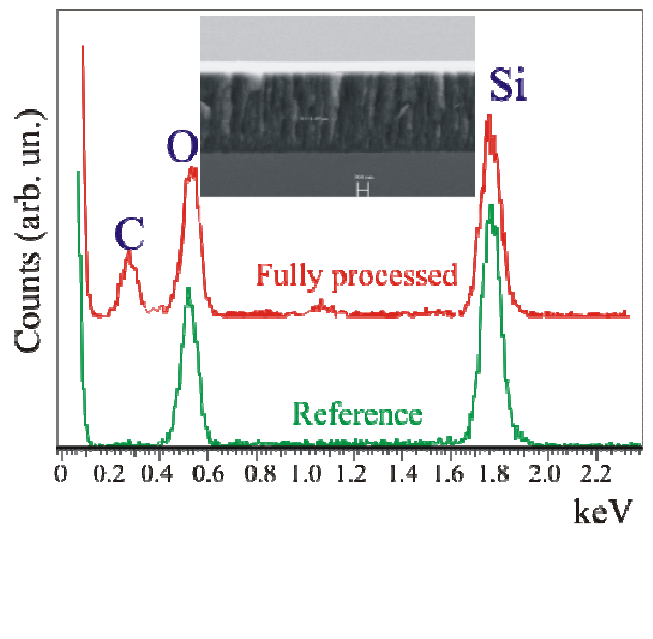
Figure 6. EDX measurements coupled to SEM on the cross section for the reference (green line) and the fully processed (Full+SSC, red line) samples. Both measurements were acquired close to the porous SiO /Si interface. In the insert the SEM image of a porous 2 sample cross section. The marker is 300 SiO 2